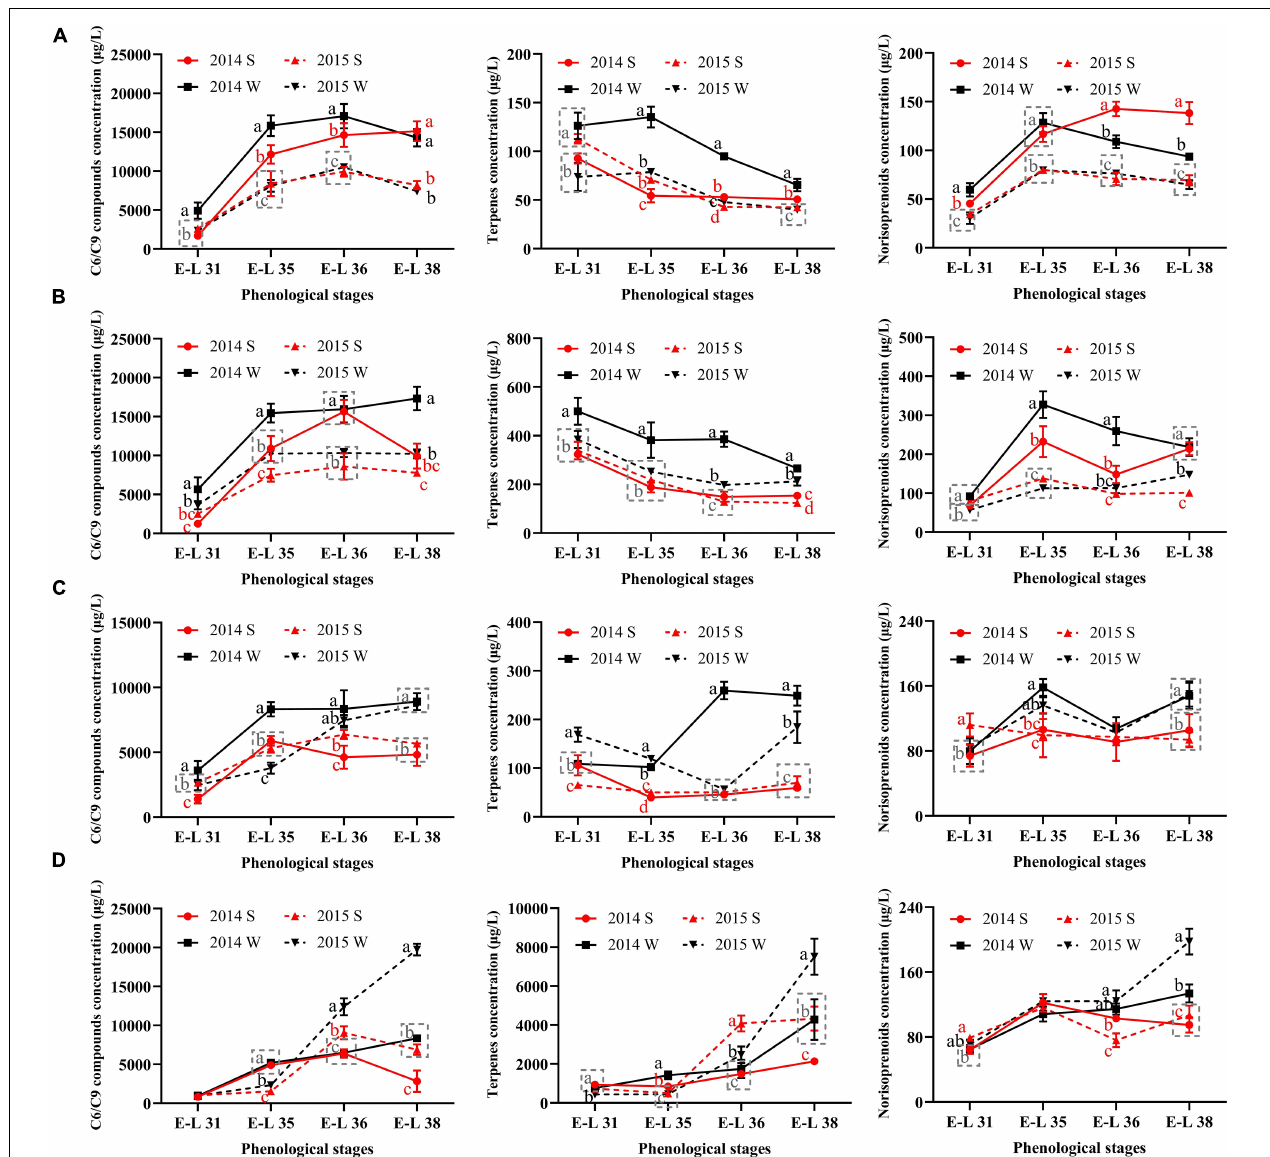
FIGURE 2 | The total concentrations of C6/C9 compounds, terpenes, and norisoprenoids in Cabernet Sauvignon (A) , Riesling (B) , Victoria (C) , and Muscat Hamburg (D) grapes in 2014 and 2015. 2014 S, 2014 summer season; 2014 W, 2014 winter season; 2015 S, 2015 summer season; 2015 W, 2015 winter season. Different letters indicate significant differences among seasons based on Duncan’s multiple range test at p <